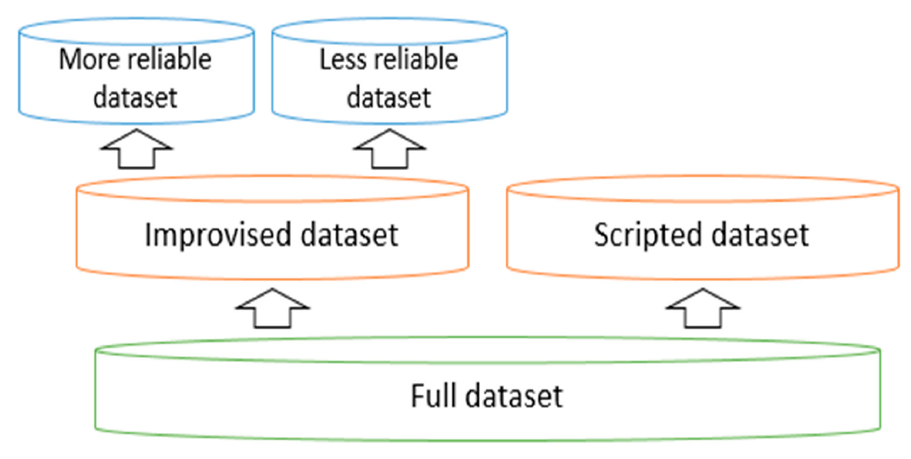
Figure 3. Interactive emotional dyadic motion capture (IEMOCAP) dataset structure. Table 1. Specifications of the improvised dataset, more reliable dataset, and less reliable dataset.